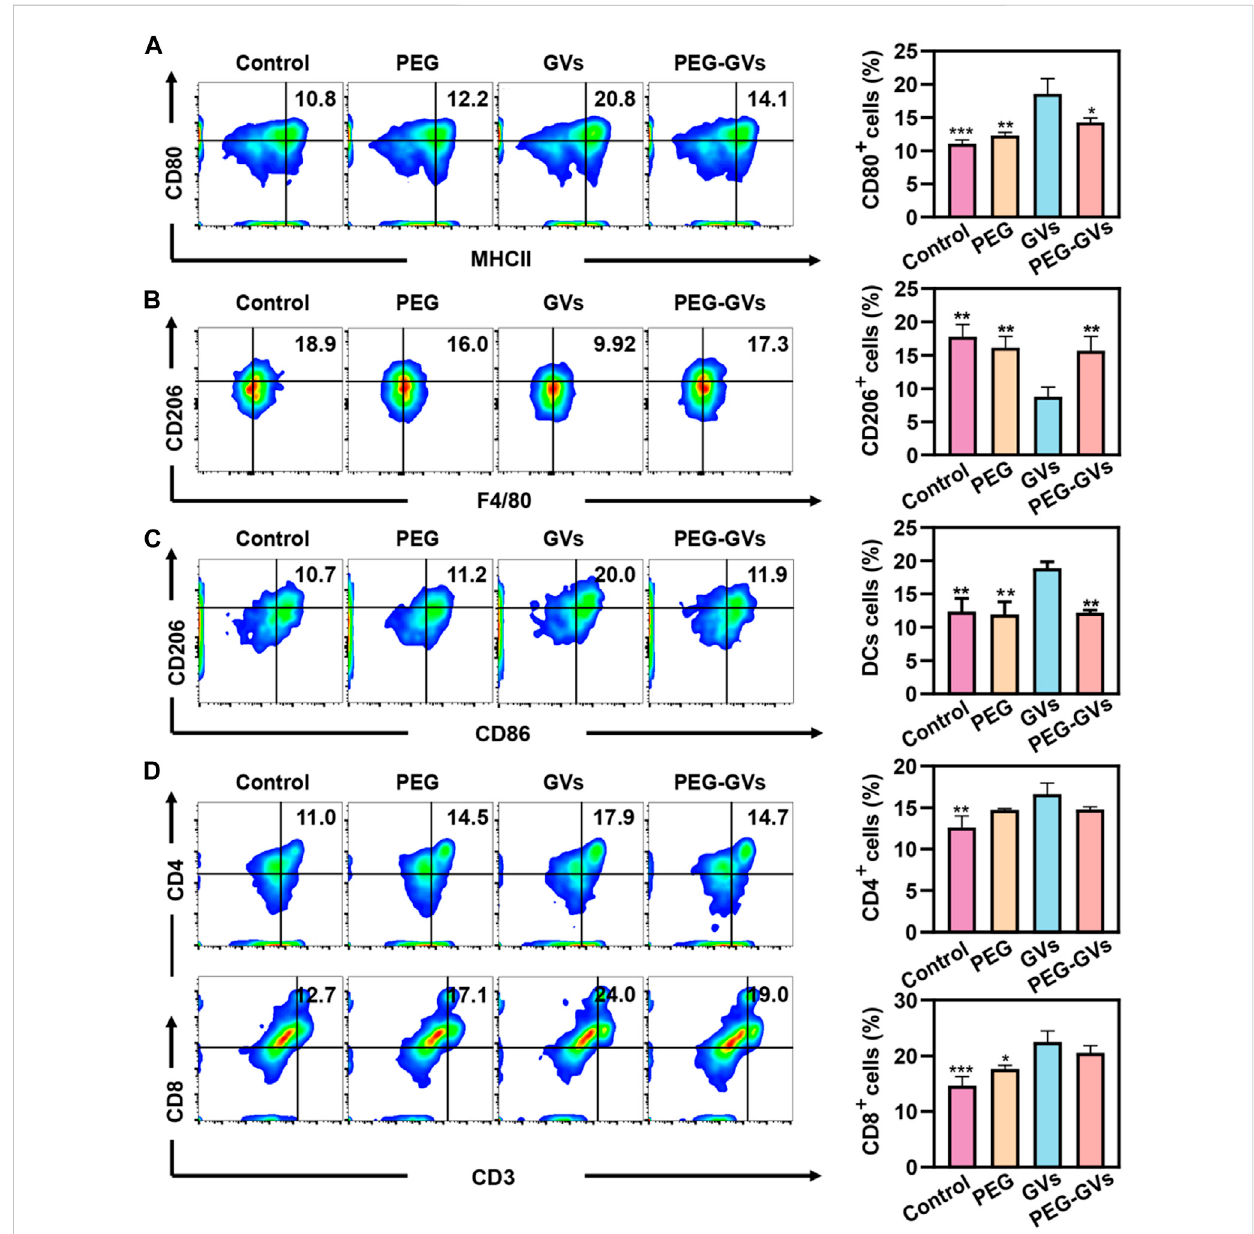
FIGURE 3 Invivo immunogenicity. (A) FlowcytometricanalysisofM1macrophages(MCHII + CD80 + )inspleen; (B) FlowcytometricanalysisofM2macrophages (F4/80 + CD206 + ) in spleen; (C) Flow cytometric analysis of DCs (CD86 + CD206 + ) in spleen; (D) Flow cytometric analysis of CD4 + T-cell (CD4 + CD3 + ) and CD8 + T-cell (CD8 + CD3 + ) in